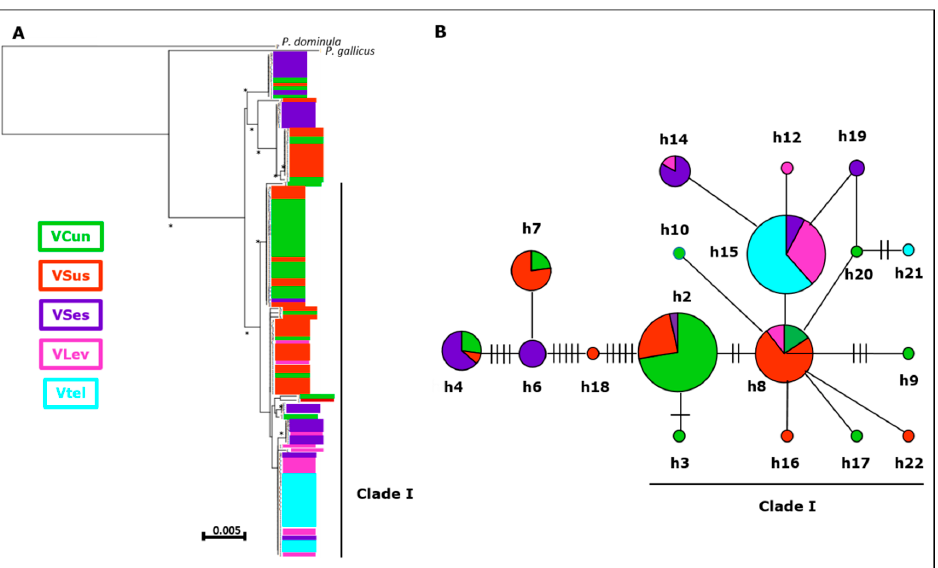
Figure 2. A schematic illustration of a neighbor-joining tree of P. biglumis mitochondrial sequences ( A ) and the minimum spanning haplotype network ( B ) based on them. The haplotypes are color coded at the region level as in Figure 1 and the largest clade I indicated with vertical ( A ) and horizontal ( B ) bars. Abbreviations of the regions are as in Table S1. In ( A ), bootstrap values > 50% are indicated with an asterisk (*). In ( B ), the size of the symbols reflects the overall frequency of the haplotype and the ticks between the haplotypes are the number of nucleotide changes between the haplotypes (no ticks = one change, one tick = two changes, etc.). Note that the haplotype codes in P. biglumis (Figure 2) and P. atrimandibularis (Figure 3) do not refer to the same sequences. Insects 2020 , 11 , x FOR PEER REVIEW